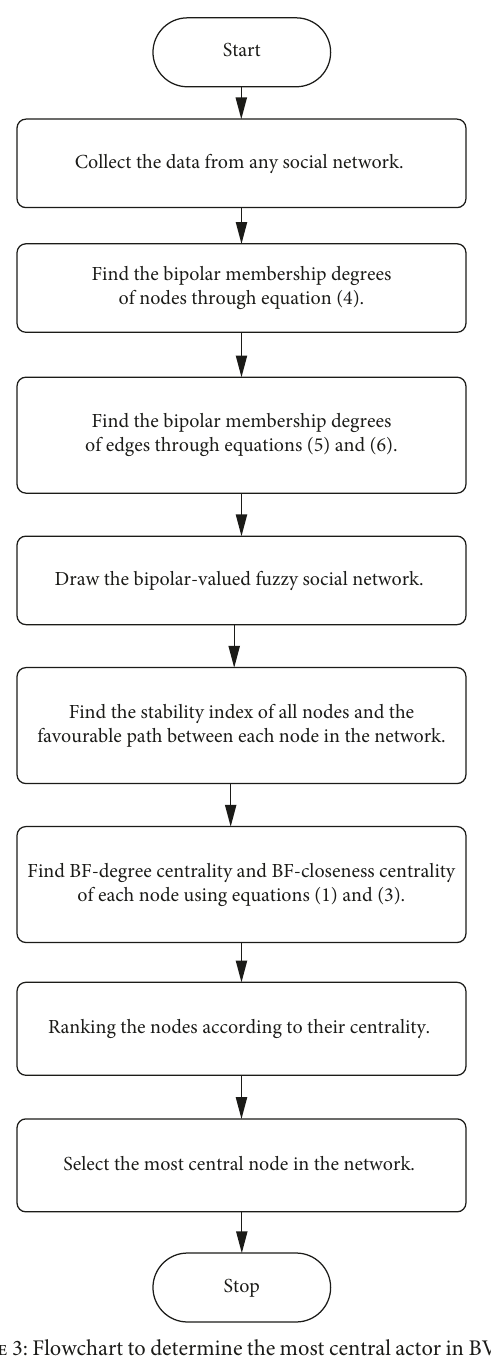
Figure 3: Flowchart to determine the most central actor in